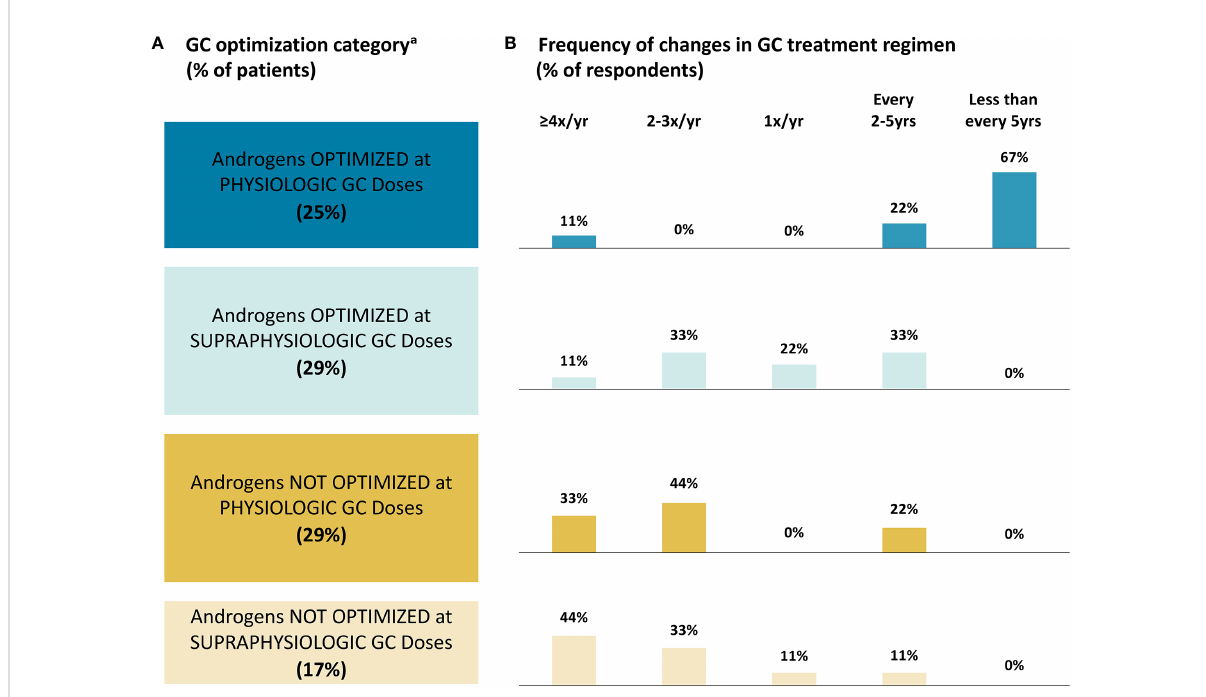
FIGURE 3 Glucocorticoid Treatment Optimization. (A) Patient Category; (B) Frequency of Changes. a The survey questionnaires did not de fi ne “ optimized ” androgen levels or “ physiologic ” GC doses; therefore, panelists reported percentages of patients in each category based on their own de fi nitions of optimized androgens and physiologic GCs. GC, glucocorticoid; yr,